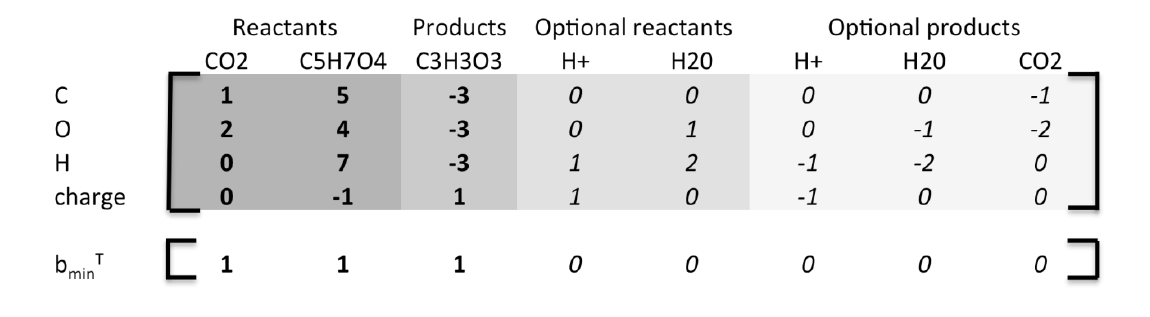
Figure 4: A matrix representing elemental count and charge of reactants and products in the reaction 2-Acetolactate + carbon dioxide ⇔ Pyruvate. Required reactant and product elemental and charge counts are specified in bold; those of optional reactants and products in italics. The , representing the minimum permitted stoichiometric coefficients for each reaction vector b min participant, is also